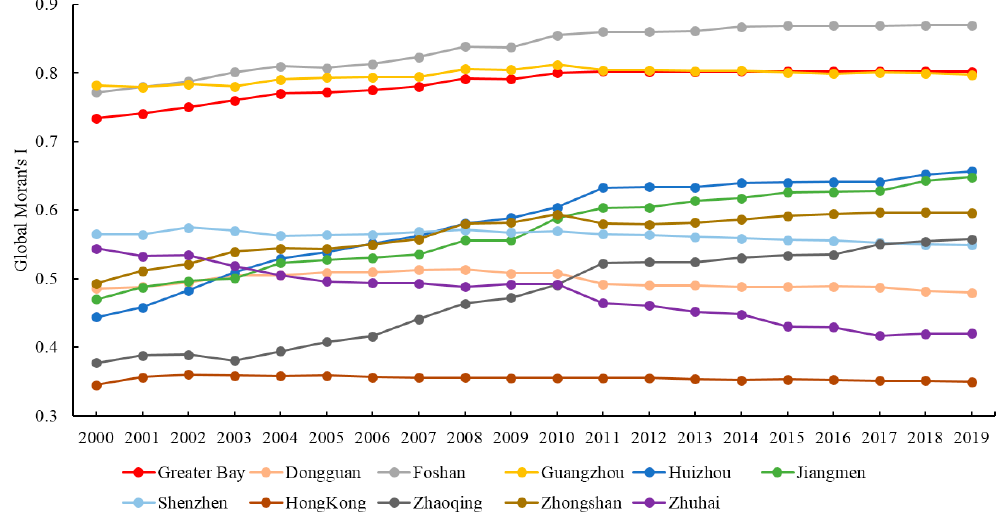
Figure 8. Annual dynamics of Global Moran’s I values.